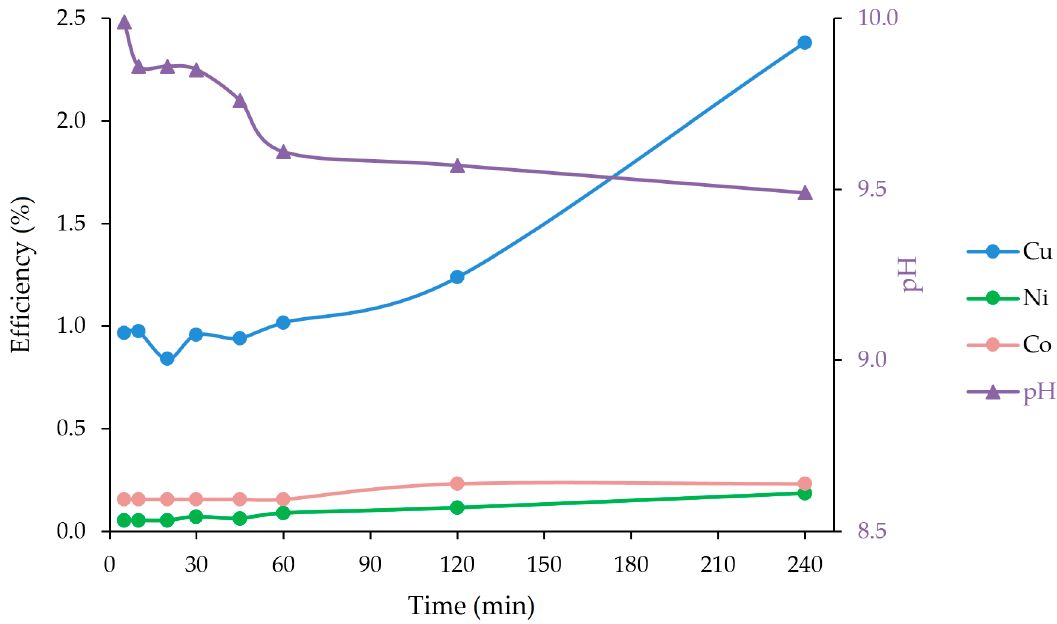
Figure 1. Kinetics of metals extraction during ammoniacal leaching at room temperature.